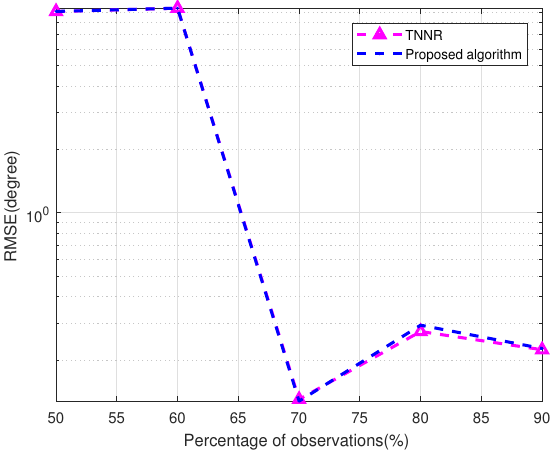
Figure 9. RMSE versus percentage of